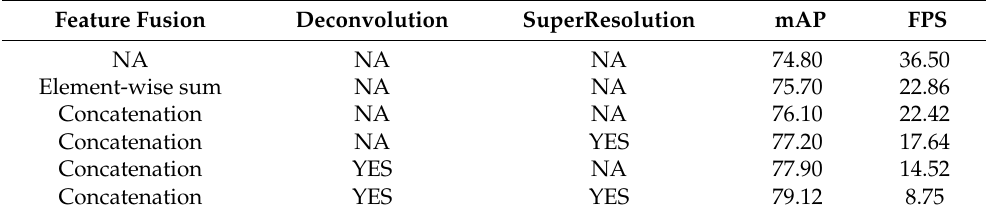
Table 4. Ablation study of the proposed network on the livestock dataset. Different combinations of the feature fusion methods, super-resolution, and deconvolution were evaluated based on mAP and